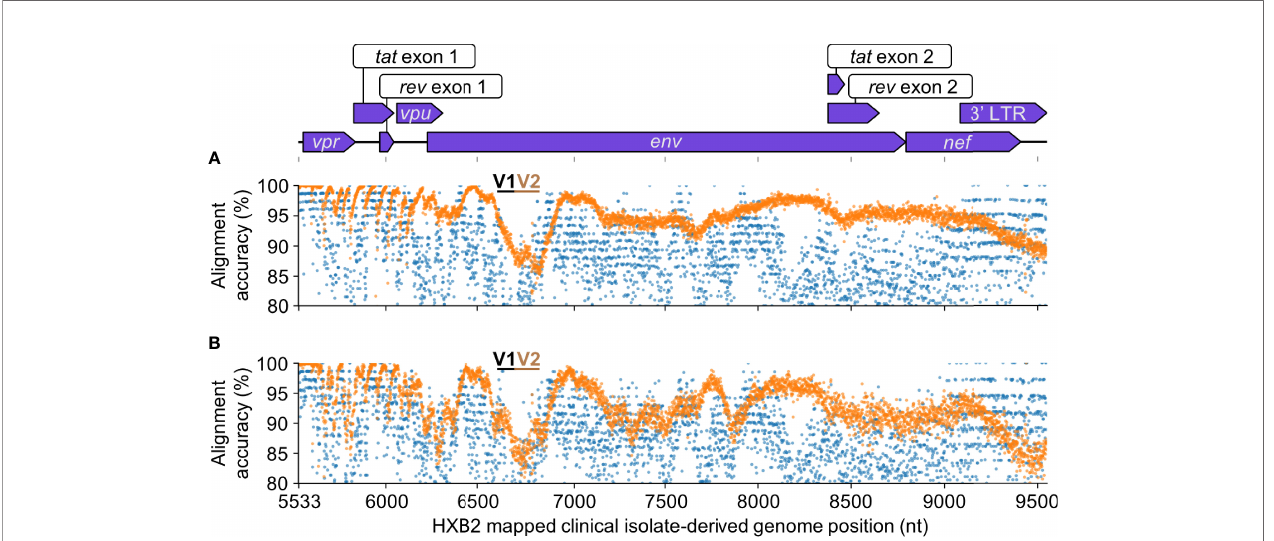
FIGURE 12 | HIV-Quasipore improved read quality across the unseen clinical isolate-derived HIV-1 genome. Each point represents the average alignment accuracy from reads overlapping a position within the clinical isolate-derived HIV-1 reference genome for (A) R10.3 SUP and (B) R10.3 HAC basecallers. Orange points represent HIV-Quasipore basecallers while blue points represent their pretrained counterparts. Clinical isolate genome coordinates are mapped to their HXB2 equivalent positions. Features present within the clinical isolate-derived genome are displayed above the graphs. Positions encompassing the V1 and V2 loops within gp120 are signi fi ed using black and gold dashes,